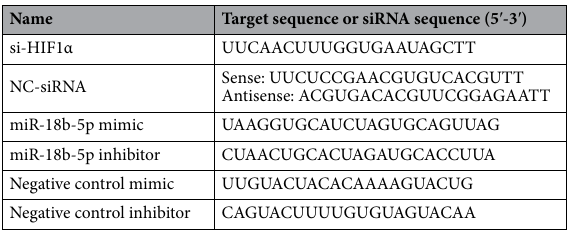
Table S1. The overexpression plasmid of PHF2 and scrambled vectors (Table S2) were purchased from Gene- Chem (Shanghai, China). Lipofectamine 2000 (Invitrogen) was utilized for the transfection. For the co-trans- fection of miR-18b-5p mimic and PHF2 overexpression plasmid, appropriate number of cells (20 × 10 4 /well) were inoculated in 6-well plates 1 day before transfection. And 4 μg PHF2 overexpression plasmids and 50 nM miR-18b-5p mimic were co-transfected into MG-63 and 143b cells. And 48 h later, the cells were harvested for further analysis. qRT-PCR and Western blotting was conducted to assess the transfection efficiencies. The cor- responding sequences were listed in Table 1. Reverse transcription quantitative polymerase chain reaction (RT‑qPCR). The cells (50–80 × 10 5 /